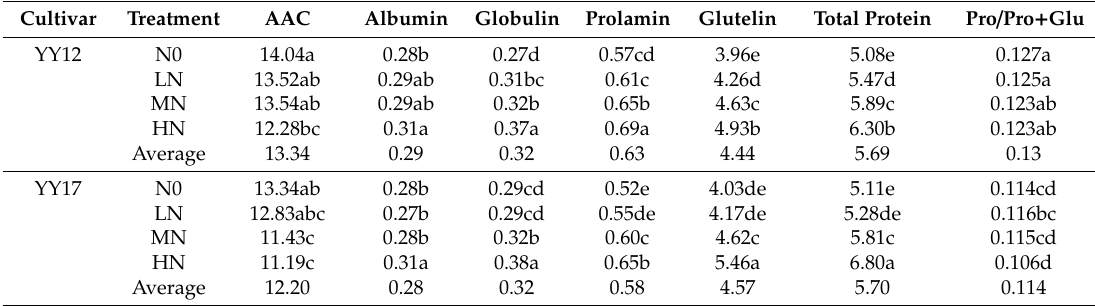
AAC, apparent amylose content and pro/pro+glu, the ratio of prolamin to prolamin+glutelin. Values with different letters in a column represent a significant difference ( p < 0.05).